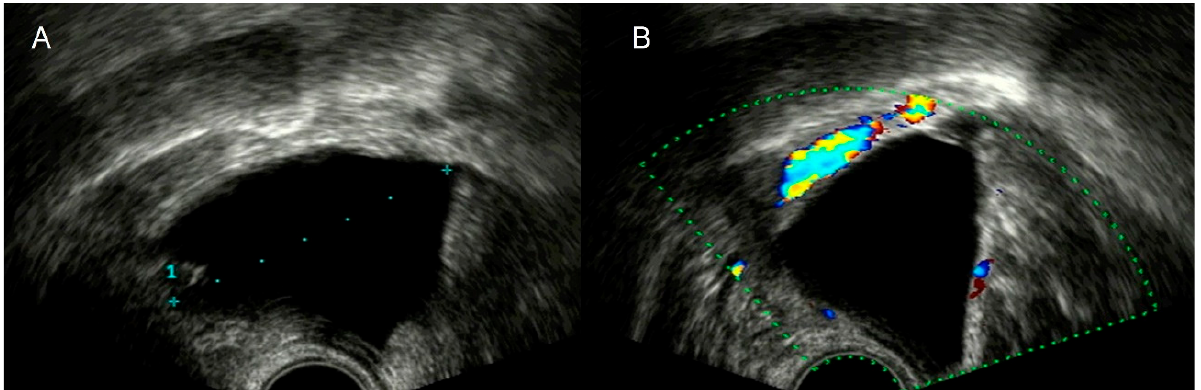
Figure 24. ( A , B ) Cystic lesion related to iliac vessels in a patient with previous lymphadenectomy consistent with lymphocele.